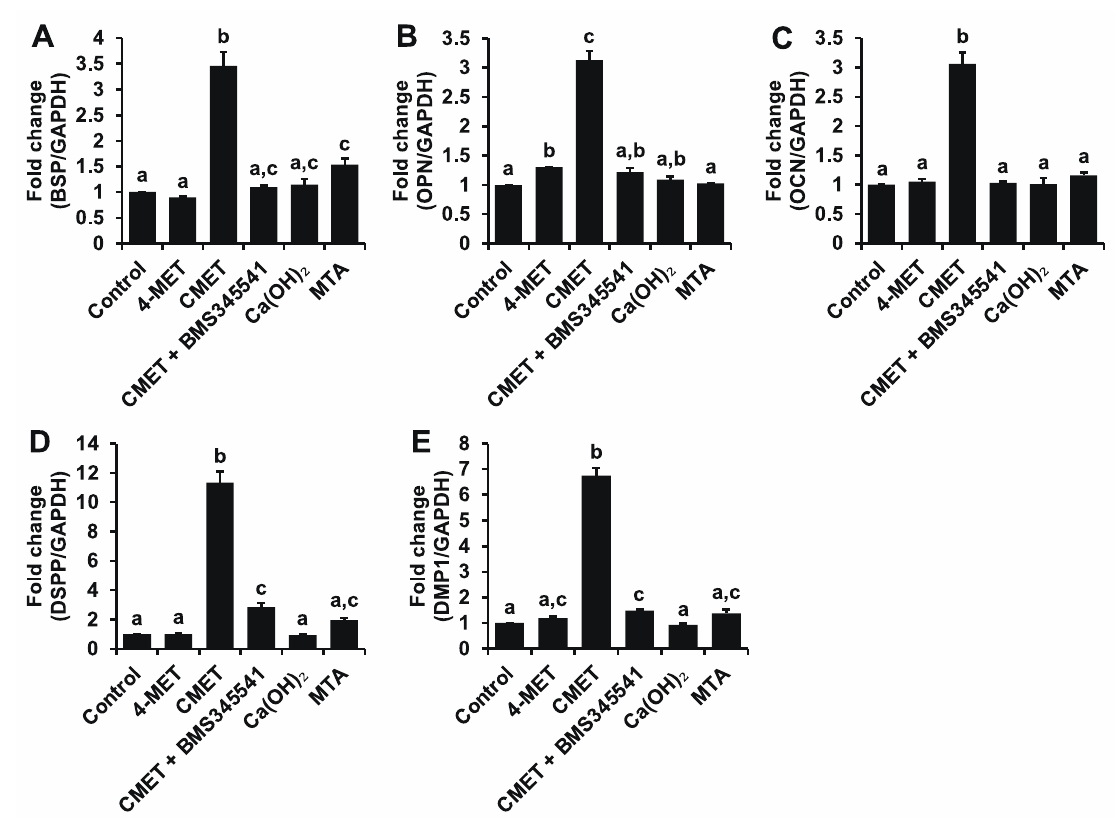
Figure 3. Effects of the aqueous solutions on the mRNA expression of odontogenic differentiation markers. Cells were cultured in DMEM supplemented with 10% FBS and 1% antibiotics. Then, 10 mM β -GP, 50 μ g/mL AA, and each aqueous solution at 5% ( v / v ) were added upon confluence, and dH 2 O was employed as a control. The mRNA expression of BSP ( A ), OPN ( B ), OCN ( C ), DSPP ( D ), and DMP1 ( E ) was upregulated by CMET treatment to different extents. These increases were abrogated by the addition of the NF- κ B pathway inhibitor BMS345541. GAPDH was used as an internal standard. n = 3, different lowercase letters indicate a significant difference ( p < 0.01).